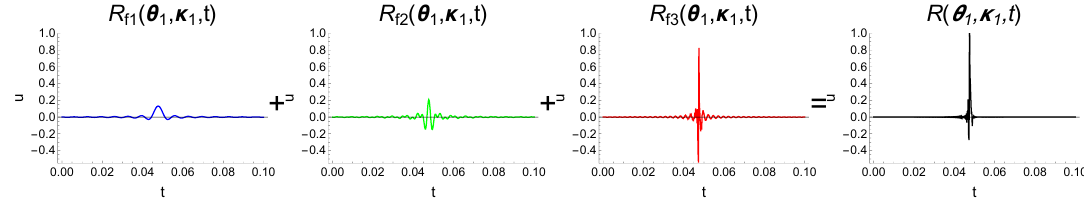
Figure 13. Impulse responses R f truncated to frequency regions f1 (blue), f2 (green) and f3 (red). Adding up the time series yields a broadband impulse response R ( Θ l , κ a , t ) (black). Here, t is the time in seconds and u is a normalized voltage to drive the